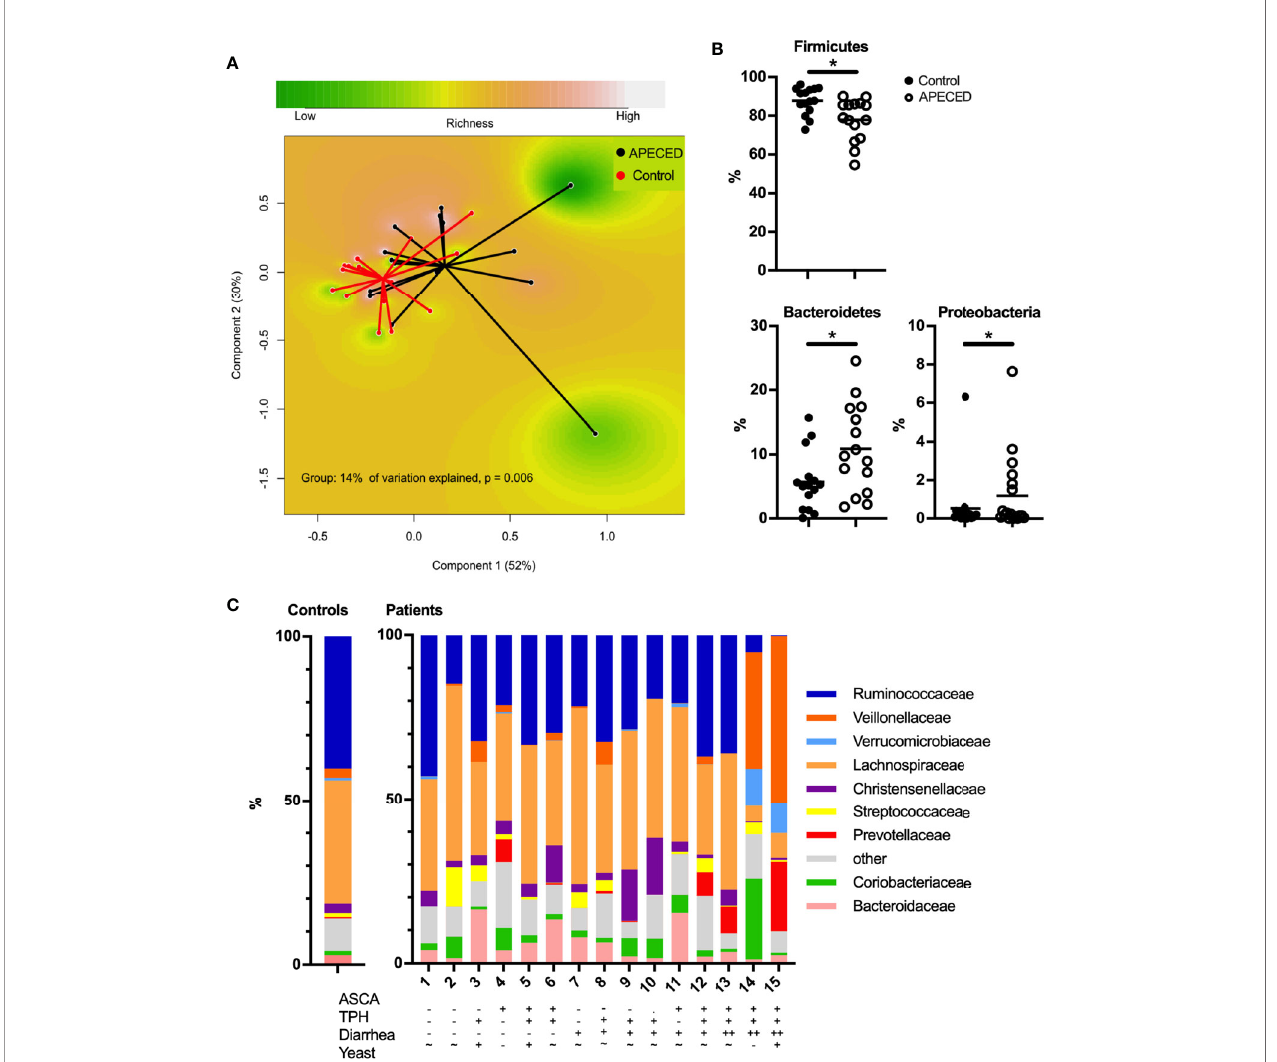
FIGURE 1 | (A) Principal coordinate analysis (PCoA) based on Bray – Curtis distances using the phylum-level data showing differences in the gut microbiota compositions between patients with APECED (black) and healthy controls (red). (B) The relative abundances of Firmicutes, Bacteroidetes and Proteobacteria in patients with APECED (open circles) compared to healthy controls (black circles). * indicates FDR- P -value < 0.05 (C) Composition of the gut microbiota at the family level of patients with APECED and healthy controls. For readability, the composition of the controls is shown as mean relative abundance. Anti- Saccharomyces cerevisiae antibodies (ASCA), antibodies against tryptophan hydroxylase (TPH), gastrointestinal symptoms and results of stool yeast analysis are shown for each patient. – negative/low, + positive, ++ markedly positive i.e. severe symptoms, ~